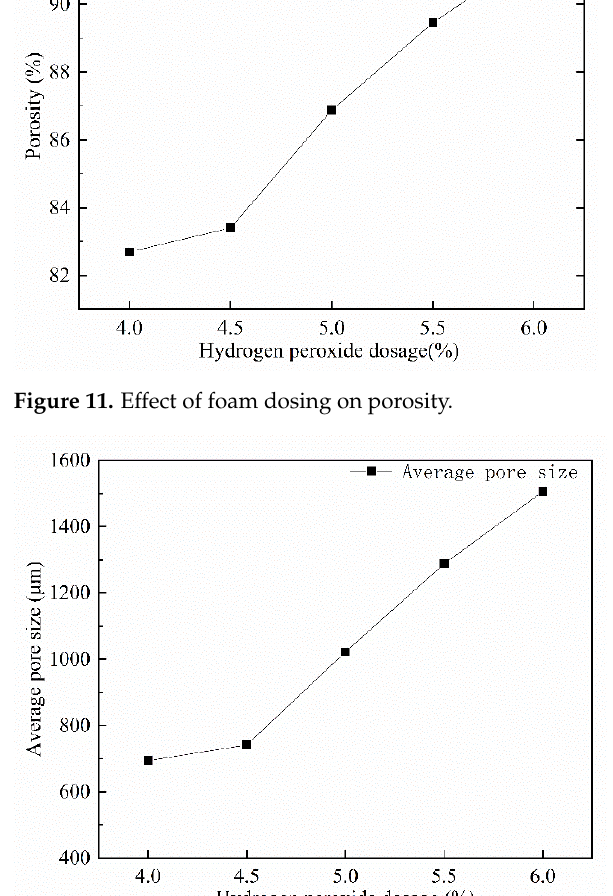
Figure 12. Effect of hydrogen peroxide on the average pore size.